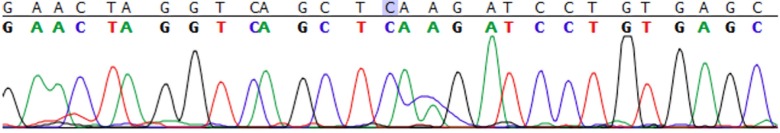
A part of the APC sequence amplified from mummy 88.Highlighted is the homozygous G→C E1317Q missense mutation.